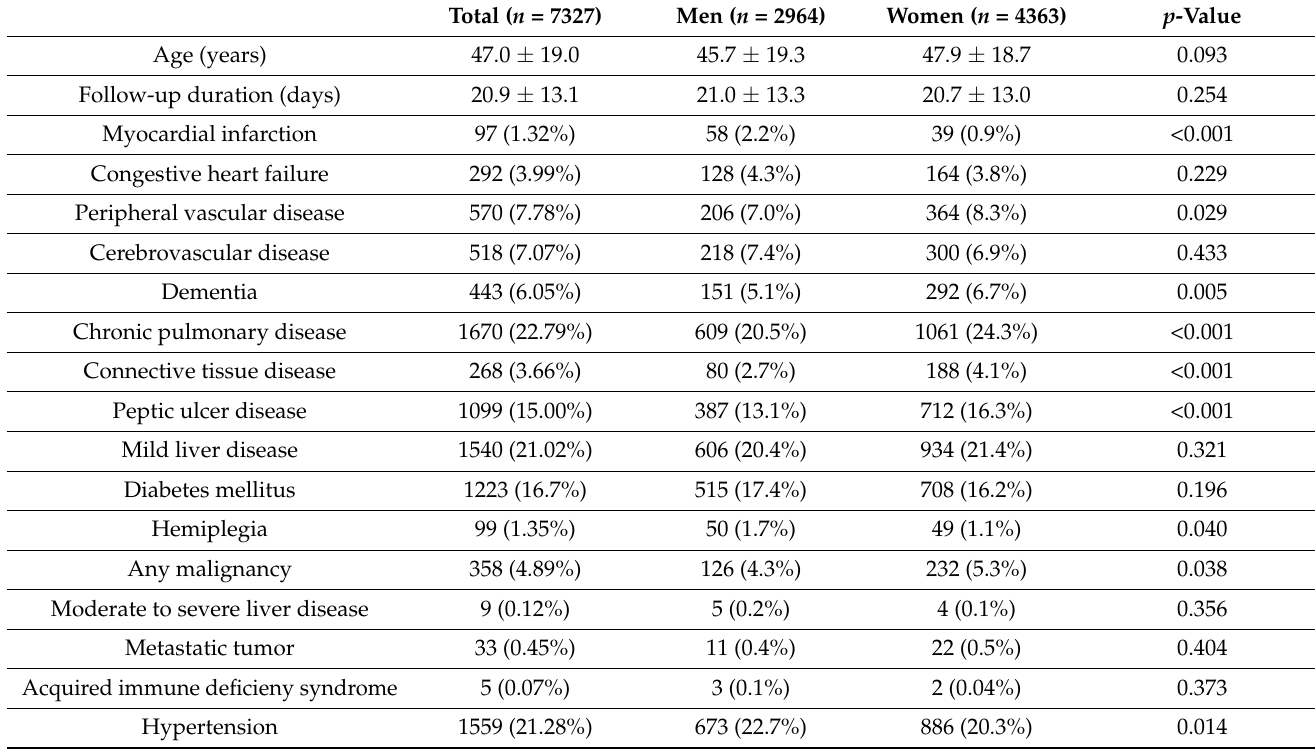
Table 1. Baseline characteristics of the